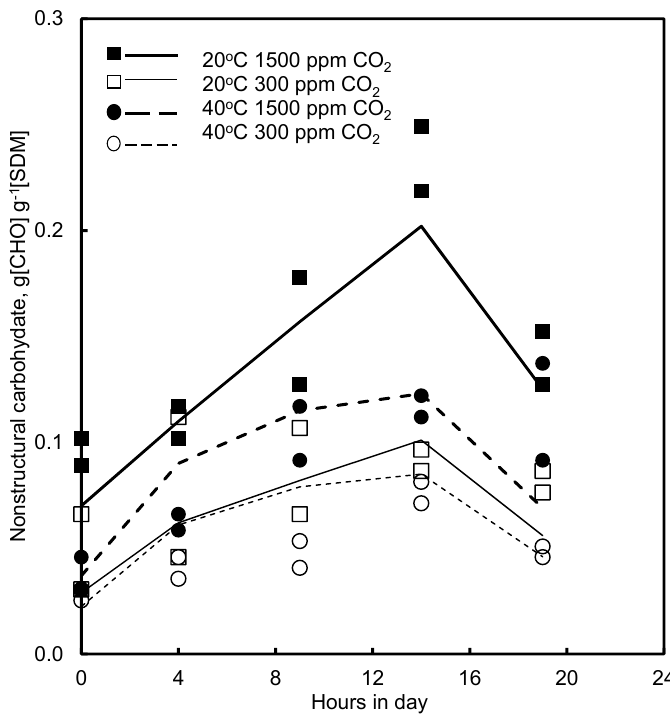
Figure 7. Diurnal variation in NSC observed for melon grown at 20 and 40 °C day temperatures, and at 300 and 1500 μ mol[CO 2 ] mol − 1 [18]. Symbols are observations from two harvests, at 11 and 22 days of treatment pooled together. Lines are predictions from the dynamic model.